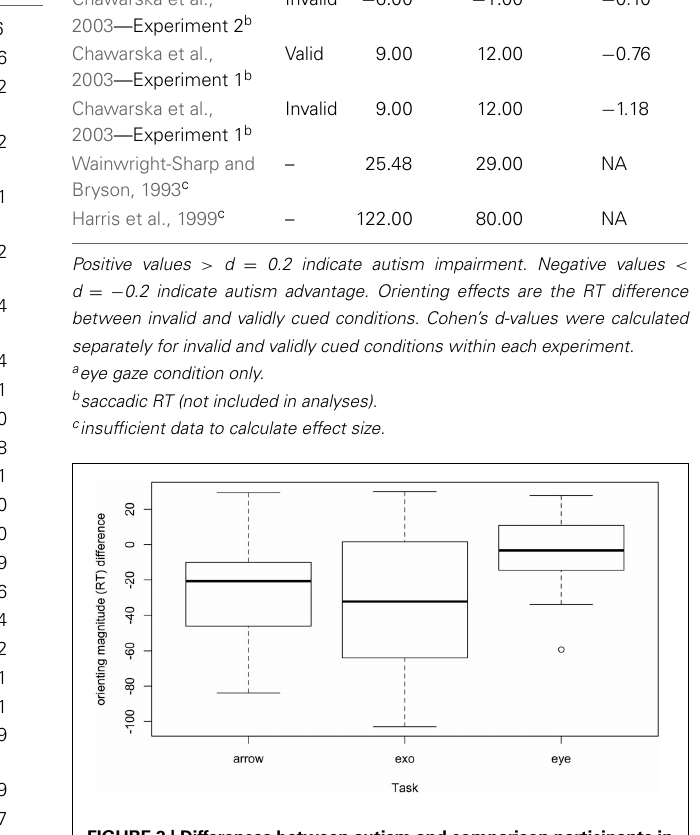
FIGURE 3 | Differences between autism and comparison participants in magnitude orienting RT. Negative values denote larger orienting effects in